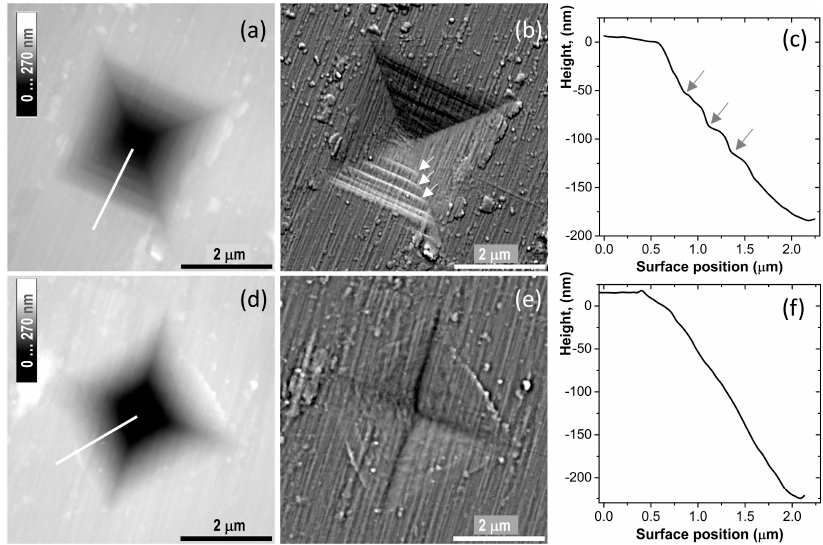
Figure 8. ( a – c ) AFM images of <100> indent and ( d –f) <110> indent on (100) cBN plane (0.49-N load): AFM topography ( a , d ) and derivative topography ( b , e ) images; and cross-section of indents ( c , f ) along the line shown in ( a , d ). Arrows indicate pronounced steps in the <100> indent aligned to <110> direction ( b ).